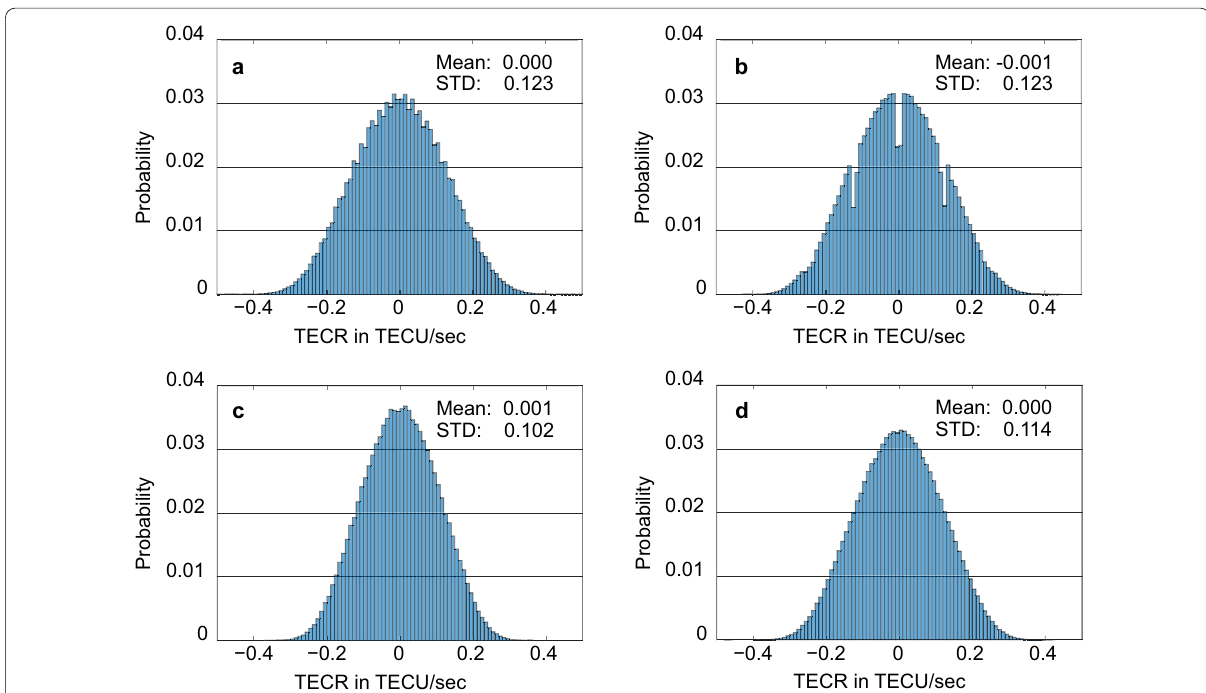
Fig. 12 Probability density distribution of the TECR derived from carrier phase measurements of GPS in ( a ), GLONASS in ( b ), Galileo in ( c ), and BDS in ( d ) collected at the static station